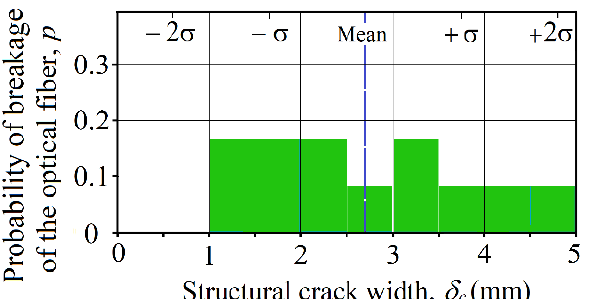
Figure 9. Probability of breakage of the optical fiber, p , as a function of the width of the structural crack that caused the fiber breakage, δ c , measured in the test specimen of brick masonry and determined for sequential intervals of a width of 0.5 mm.